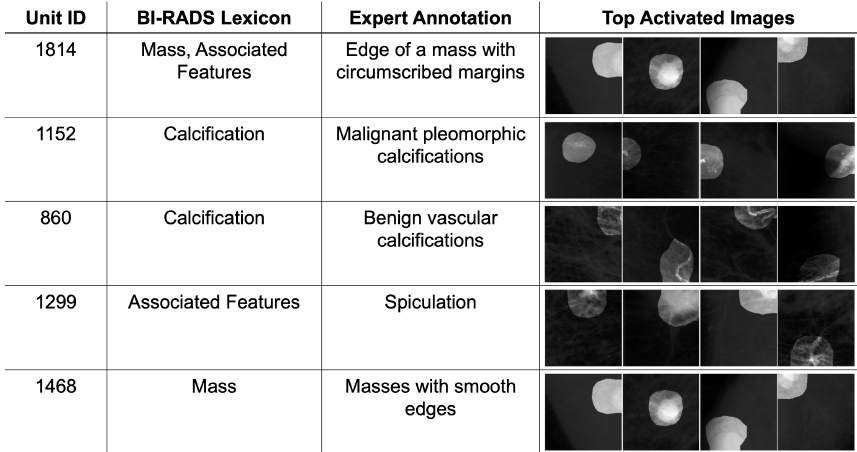
Figure 3. Interpretable units discovered by DeepMiner: The table above illustrates five annotated units from the last convolutional layer of our reference network, with asso- ciated categories from the Breast Imaging-Reporting and Data System (BI-RADS)